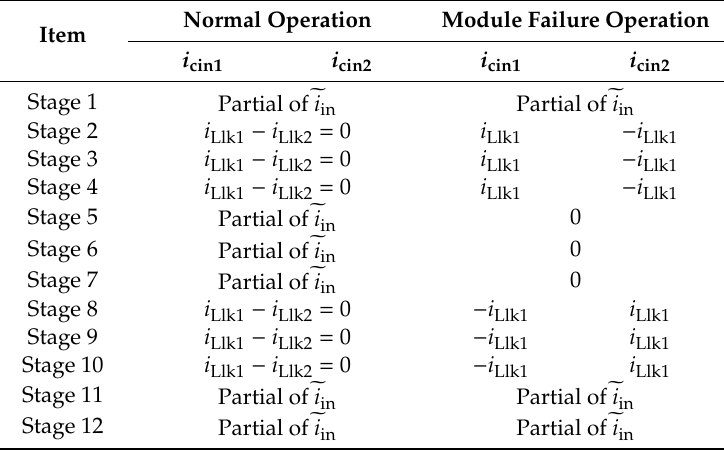
Table 6. Currents of the input capacitors during the primary side modulation.